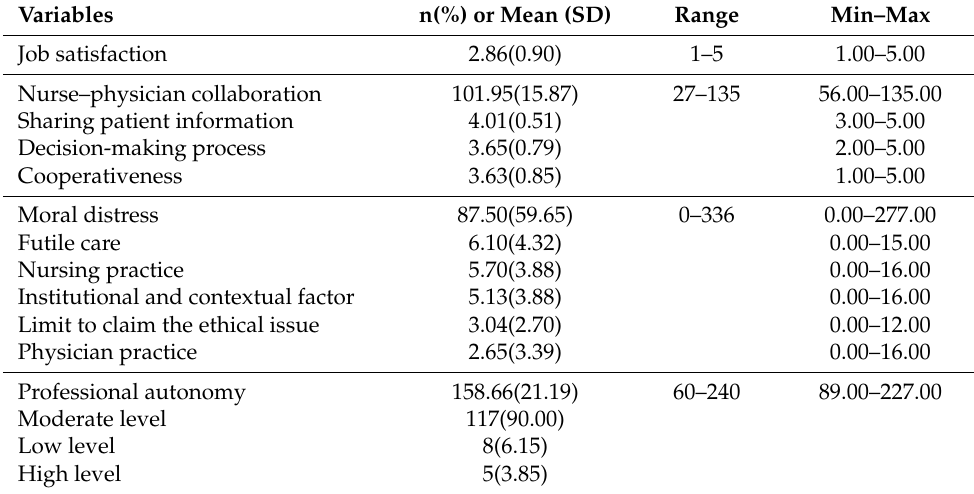
Table 2. Levels of job satisfaction, nurse–physician collaboration, moral distress, and professional autonomy (n = 130).